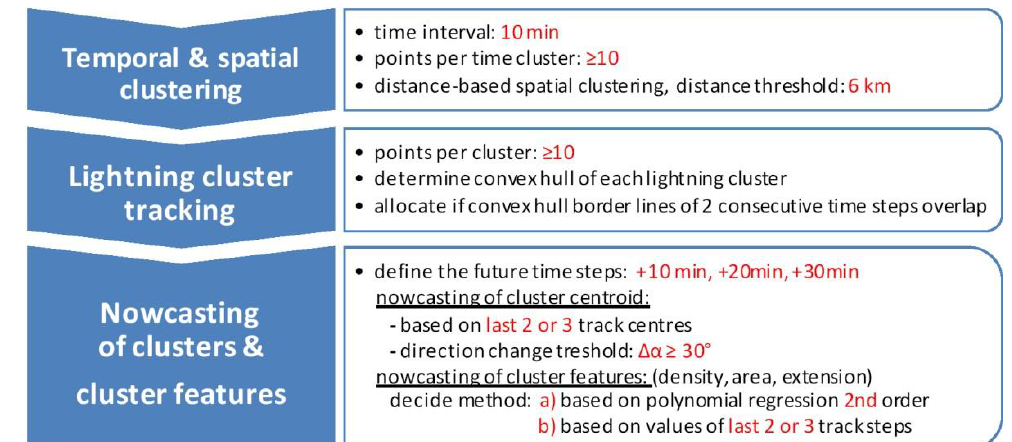
Figure 3. Adjustable parameters (in